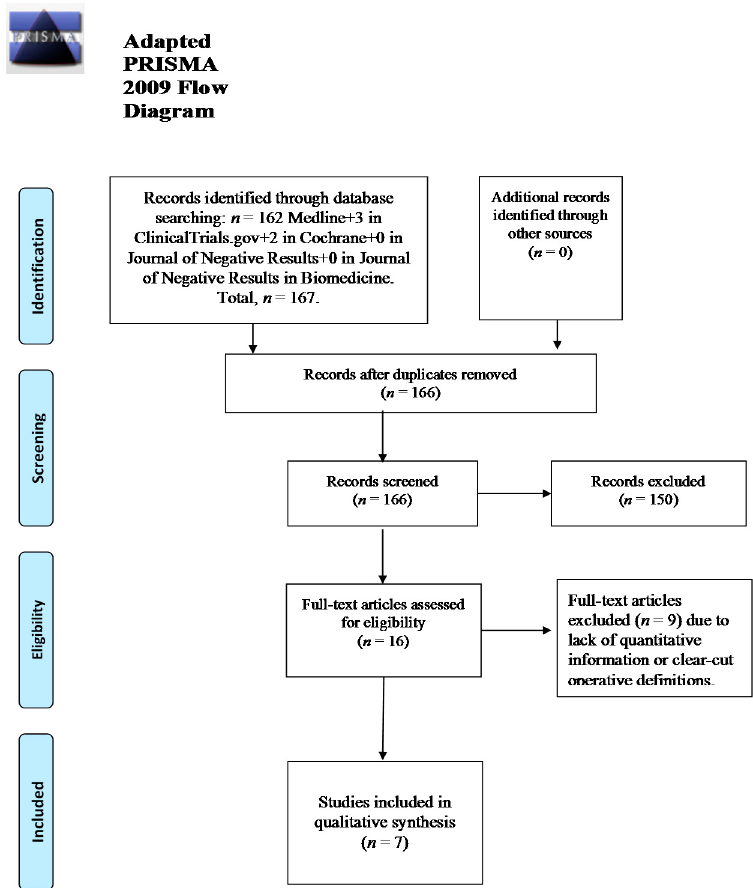
Figure 1. Flowchart of the study.